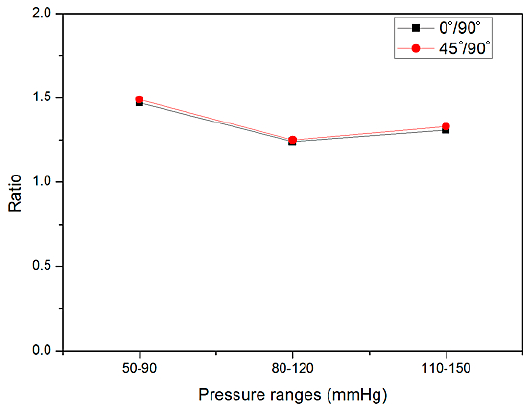
Figure 13. Ratios of diameter change in unstented zone G3 of the nitinol-PU stent graft between circumferential bar position at 0° and 90° and at 45° and 90°.